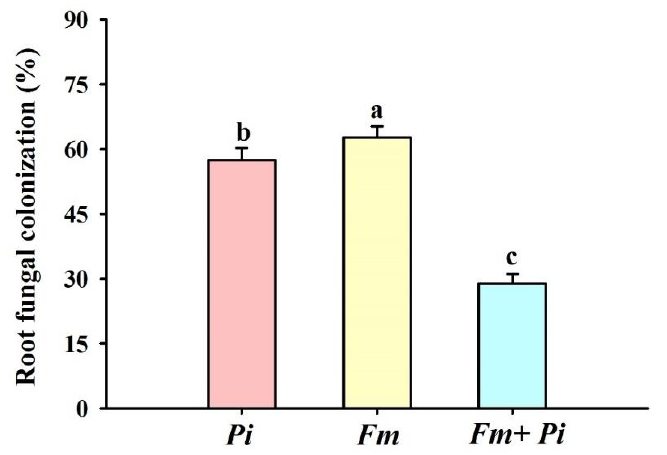
Figure 2. Effects of Piriformospora indica ( Pi ) and Funneliformis mosseae ( Fm ) singly and in combination on the root fungal colonization in trifoliate orange seedlings. Data (means ± SD, n = 10) followed by different letters above the bars indicate significant differences ( p < 0.05) between treatments.